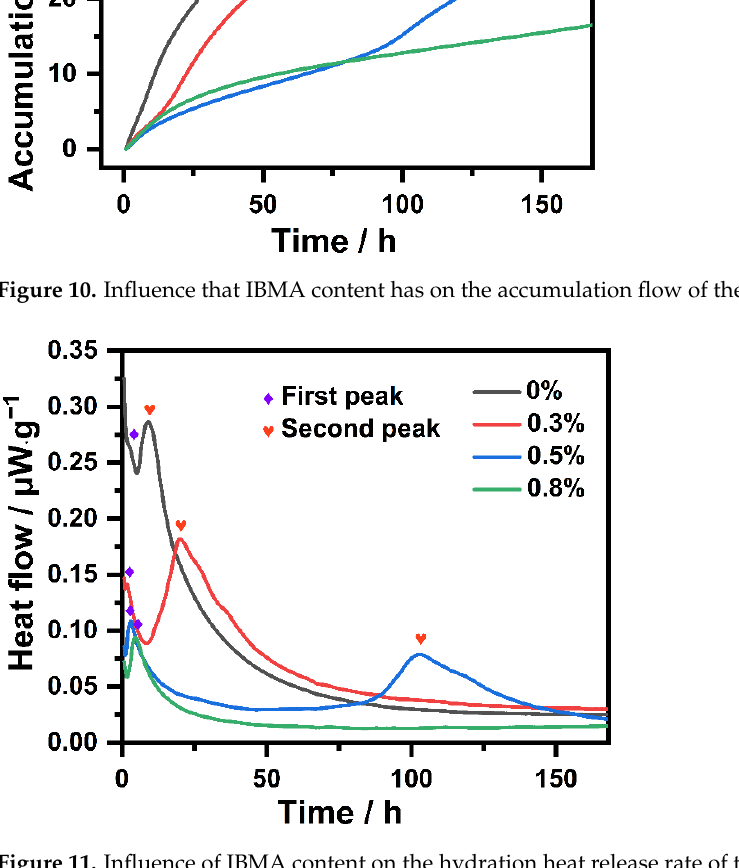
Figure 11. Influence of IBMA content on the hydration heat release rate of the hydration of NHL.